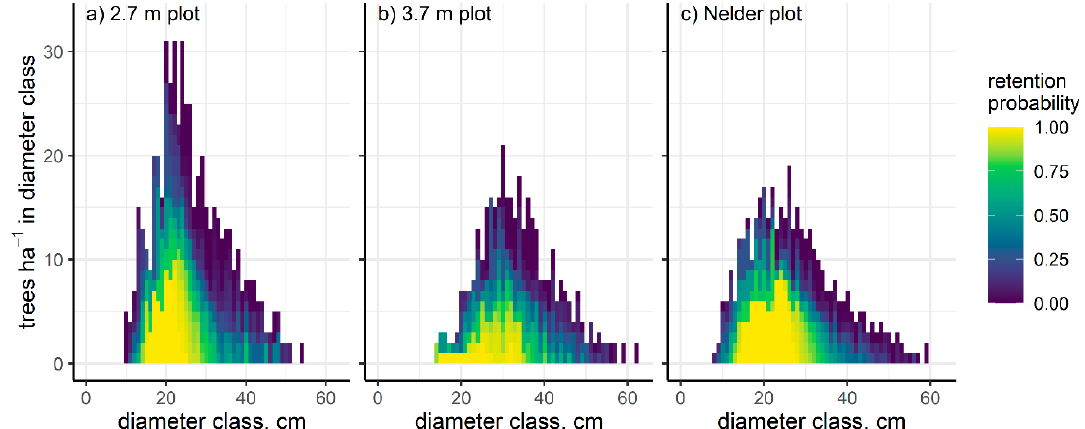
Figure 6. Retention of trees on each plot, by diameter class, resulting from heuristic optimization across all combinations of thinning age and rotation length. While the reference prescription thinned from below, heuristic tree selection typically identified complex prescriptions thinning predominantly from above.